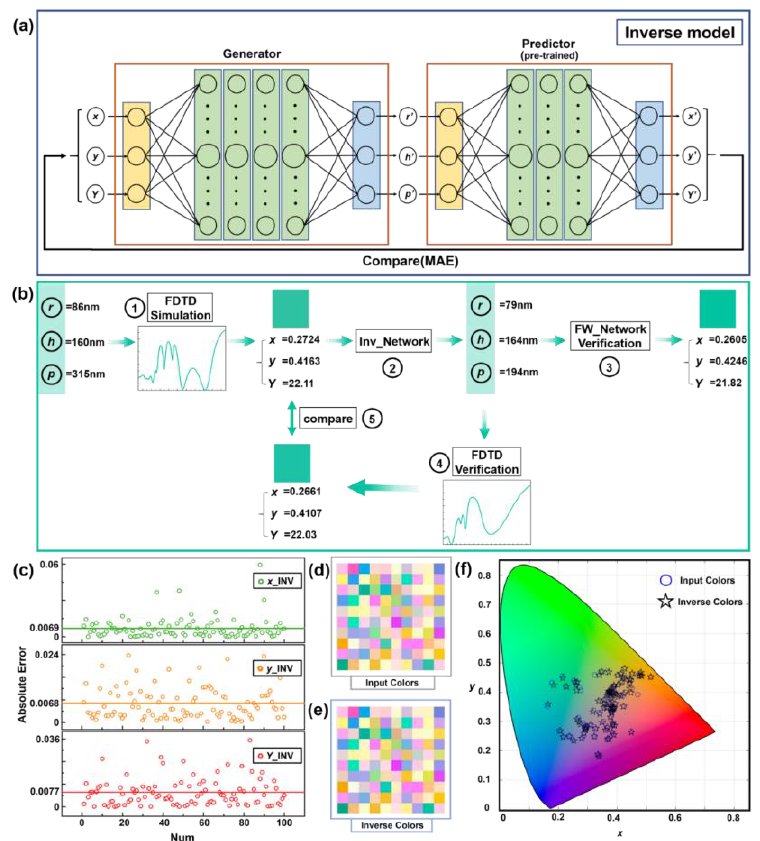
Figure 5. ( a ) Schematic of inverse ANN for predicting the micro–nano structures. ( b ) Metasurface inverse design and the results’ verification process. ( c ) The absolute error between the simulated colors and inverse-designed structural colors. ( d , e ) The 100 groups’ colors designed by FDTD and inverse ANN. ( f ) The coverage of 100 groups’ real and inverse colors by SCF on the CIE 1931 chromatic diagram. To exhibit the universality of our inverse model, 100 groups of colors are selected